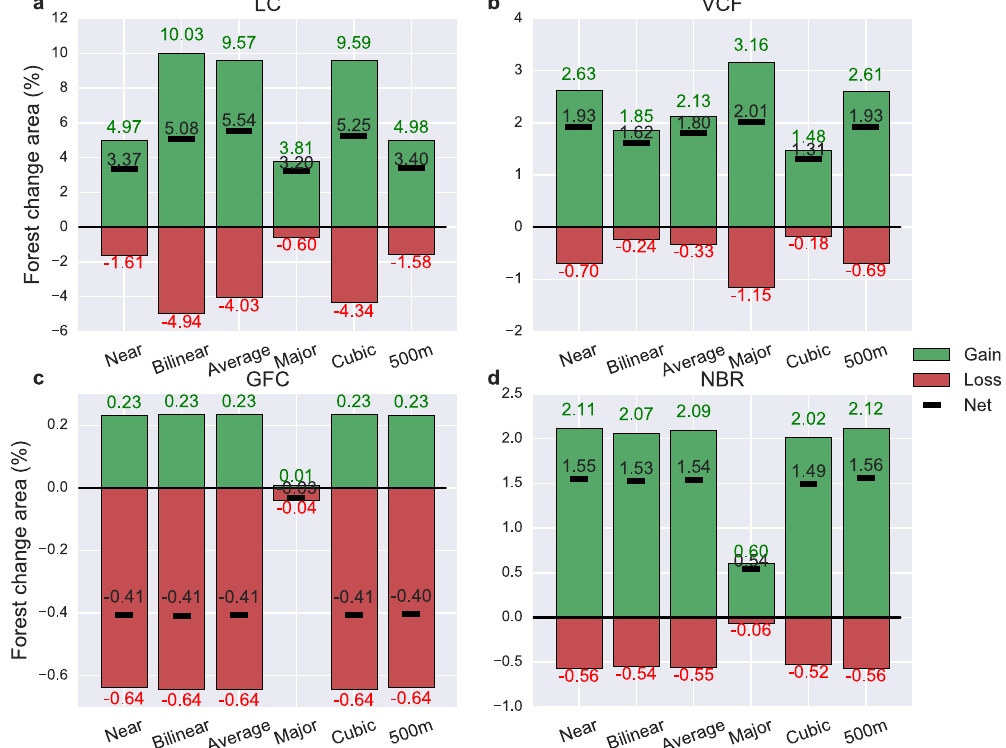
Figure 6. Forest cover change resampled from 500 m to 5 km spatial resolution for ( a ) MODIS LC, ( b ) MODIS VCF, ( c ) GFC, and ( d ) MODIS NBR using different resampling methods. Five different resampling methods were applied to emulate the range in spatial scaling processes available. These include nearest neighbor (near), bilinear, average, mode (major), and cubic from the Geospatial Data Abstraction Library. These resampled forest change estimates at 5 km were compared against the original forest change area at 500 m.